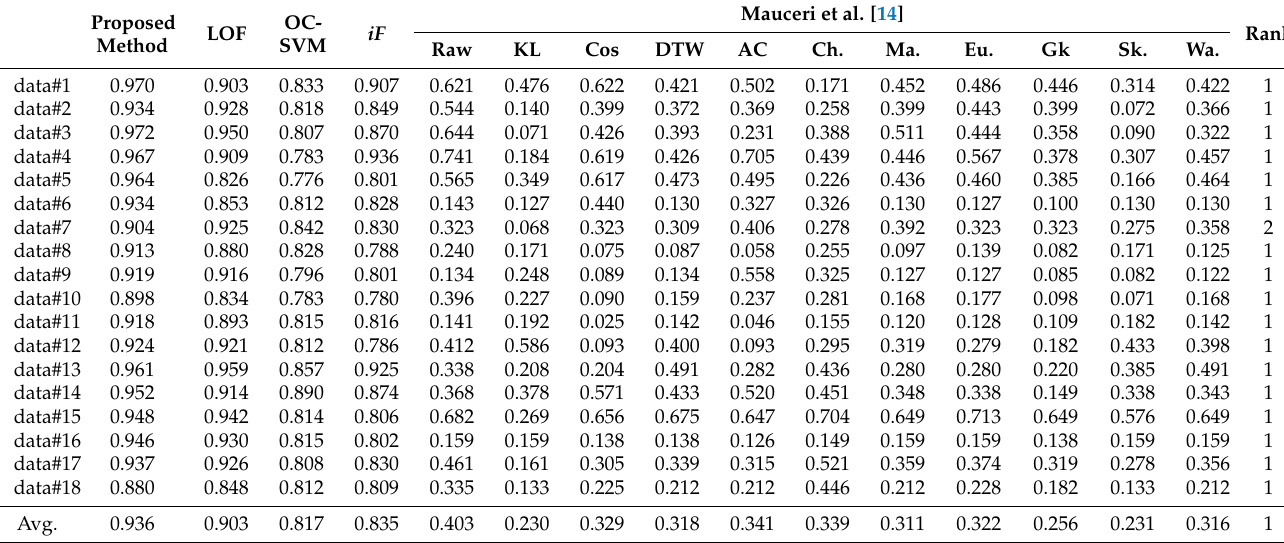
Table 2. Experimental results in terms of